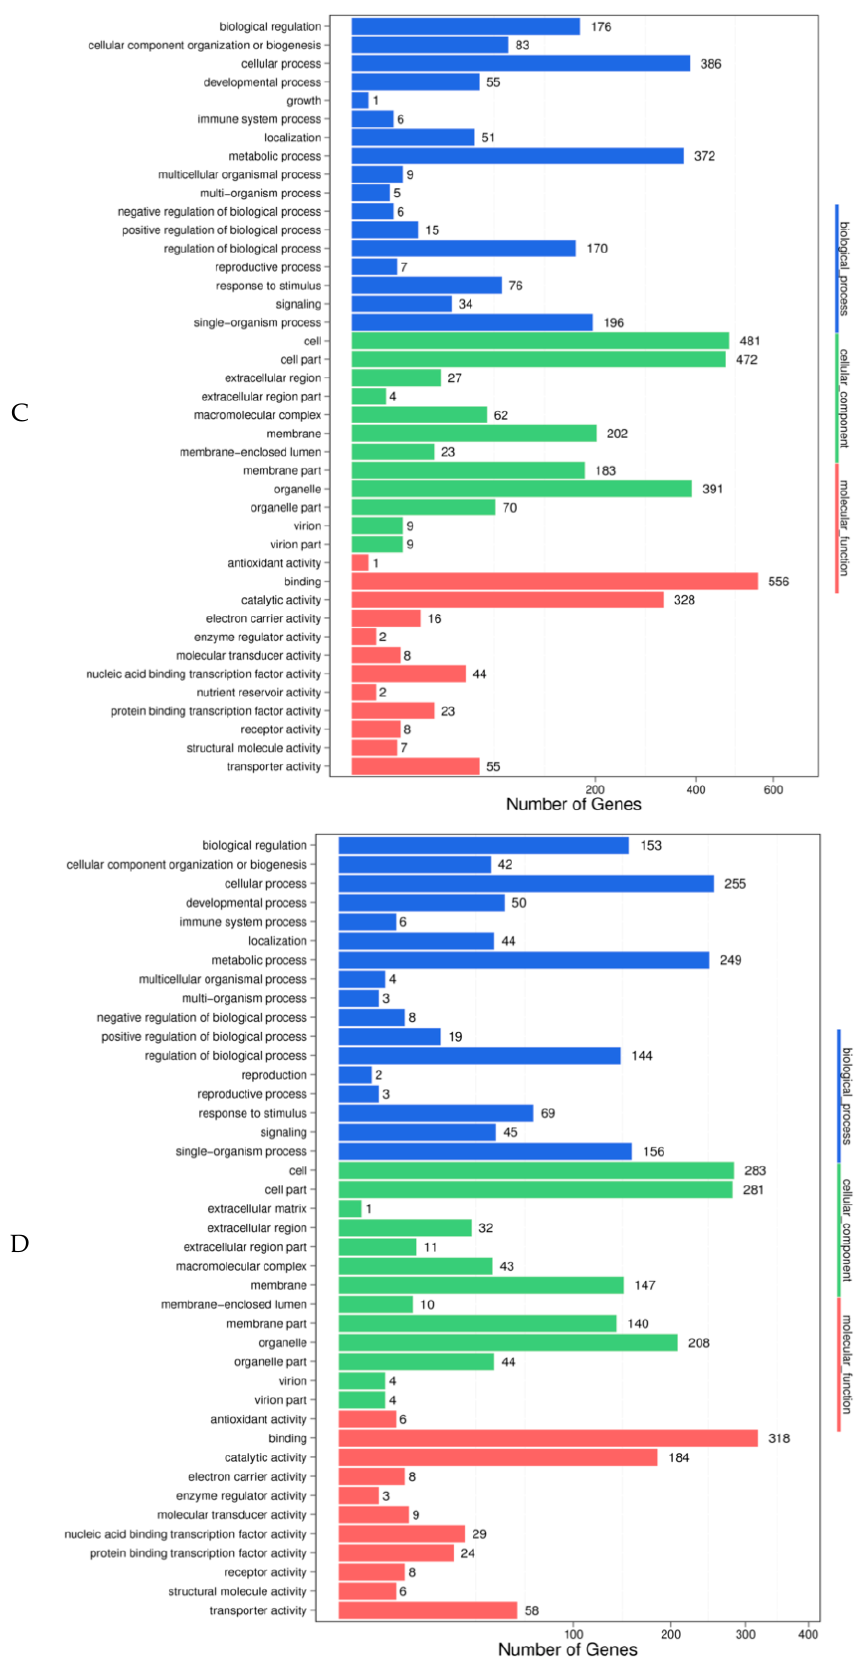
Figure 4. GO function analysis of the DEGs. ( A ) HRK48 / HRK0; ( B ) HSK48 / HSK0; ( C ) HRK0 / HSK0; ( D ) HRK48 / HSK48.